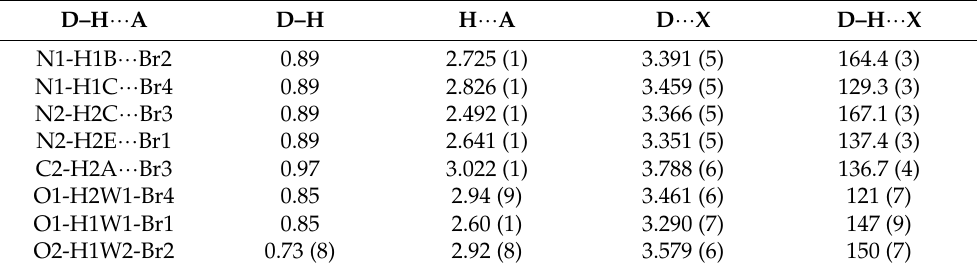
Figure 2. Partial packing diagram of (CHBMAH 2 )ZnBr 4 ·3/2H 2 O 1 viewed along the c axis and showing the H-bonding network (dashed lines). Table 2. H-bond lengths (Å ) and angles (°) in (CBMH 2 )ZnBr 4 ·3/2H 2 O 1 .